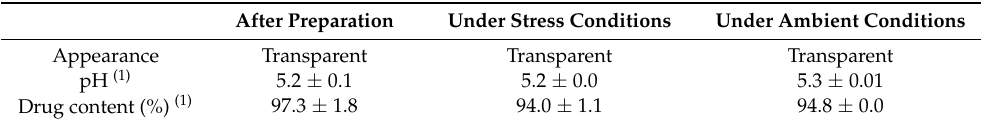
Table 5. Physicochemical stability of the optimized topical solution (LH-HS4) under stress (60 ◦ C for six days) and ambient condition (25 ◦ C for 10